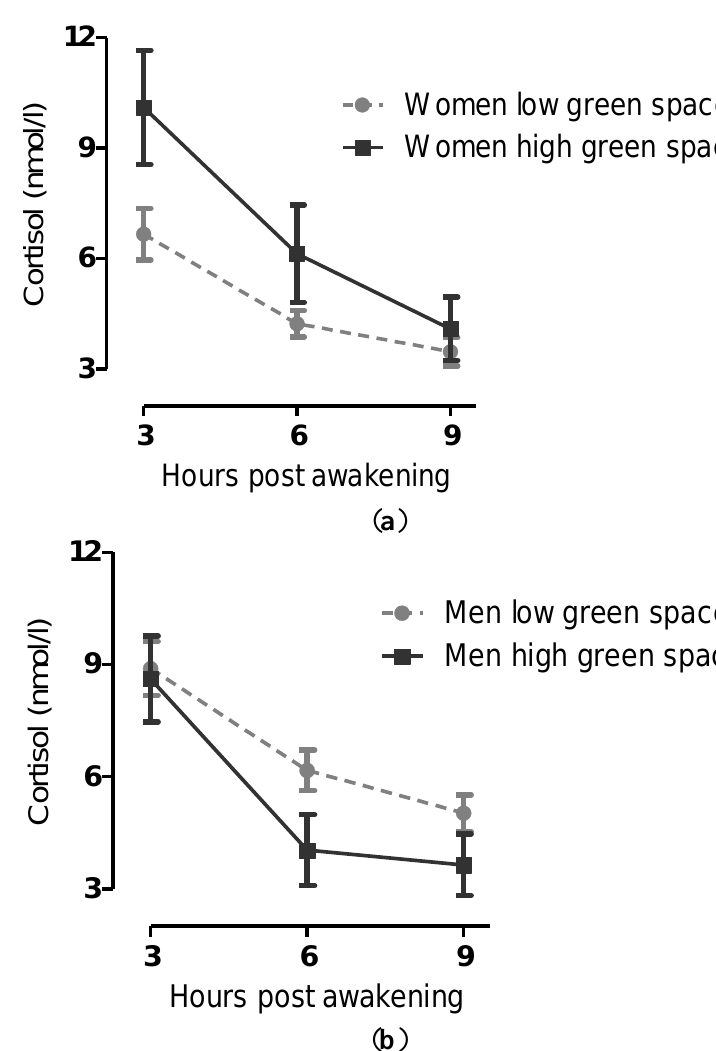
Figure 2. (a) Differences in mean cortisol slope in women living in high versus low green space areas. (b) Differences in mean cortisol slope in men living in high versus low green space